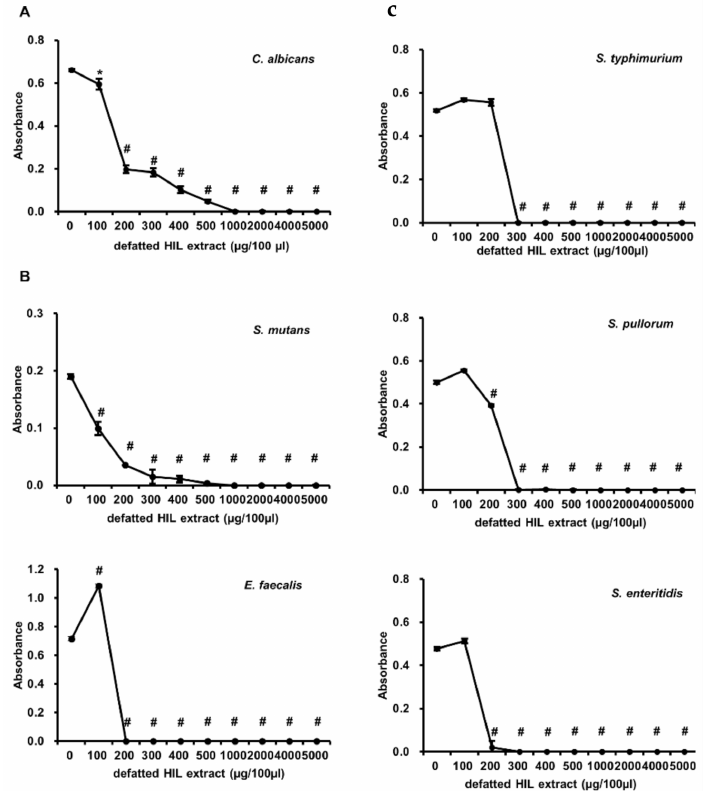
Figure 4. Antimicrobial activity of defatted HIL extracts against C. albicans ( A ), S. mutans , E. faecalis , ( B ) and Salmonella species ( C ). Briefly, 1 × 10 6 cfu/mL of 90- µ L S. typhimurium , S. pullorum , and S. enteritidis , suspensions were treated with various concentrations of 10- µ L melittin or defatted HIL extract dissolved in 0.05% acetic acid solution. Then, bacteria were grown for 24 h at 37 ◦ C. The experiments were independently performed in triplicate. A concentration of 0 µ g/100 µ L of melittin and defatted HIL extract indicates 0.05% acetic acid alone. The statistical analysis was performed by Student t -test. The significant differences were determined by comparing the absorbance of each experimental group with the control (0 µ g/100 µ L). Each value represents the means ± standard deviations of absorbance. * and # indicate p < 0.05 and p < 0.0001,